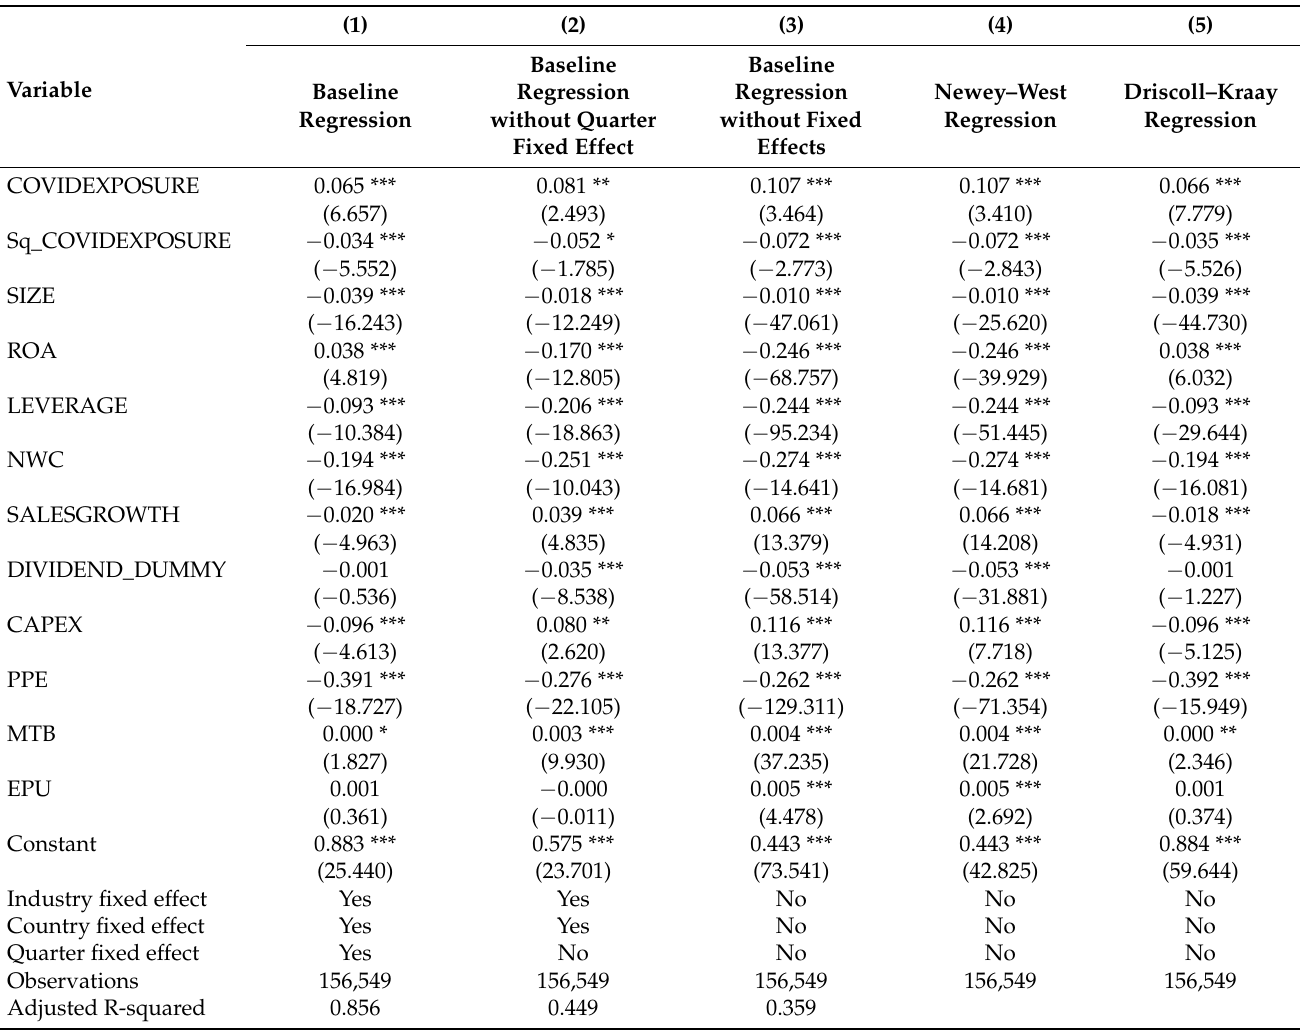
Table 4. Baseline